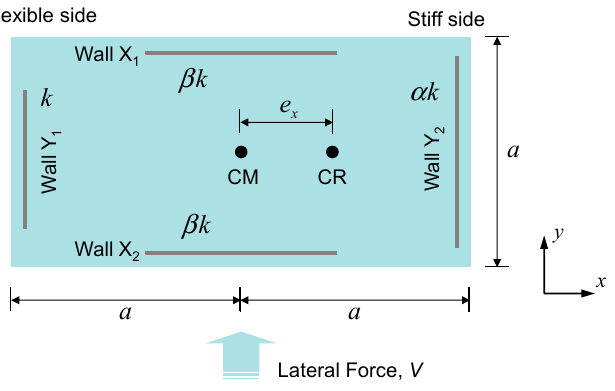
Figure 3. Model problem of a plan-asymmetric structure.